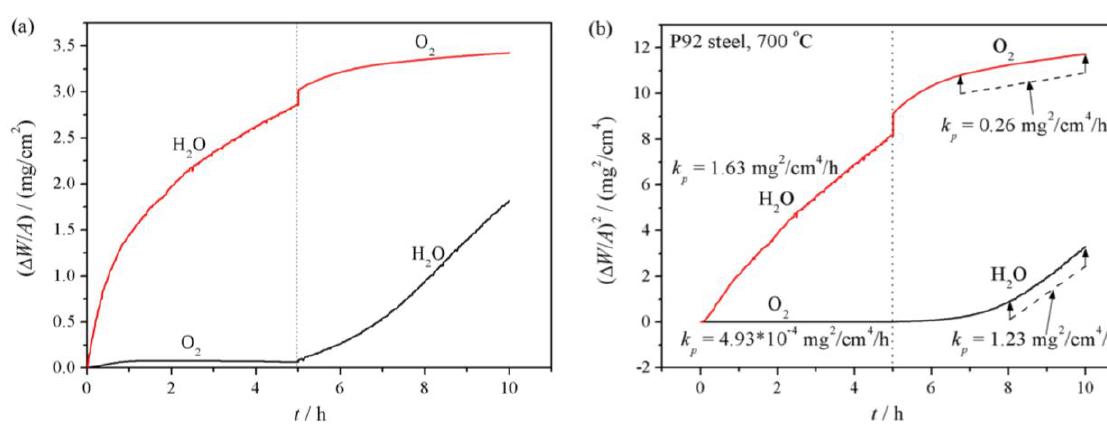
Figure 9. ( a ) Oxidation kinetics and ( b ) parabolic fitting of P92 in two-stage exposures at 700